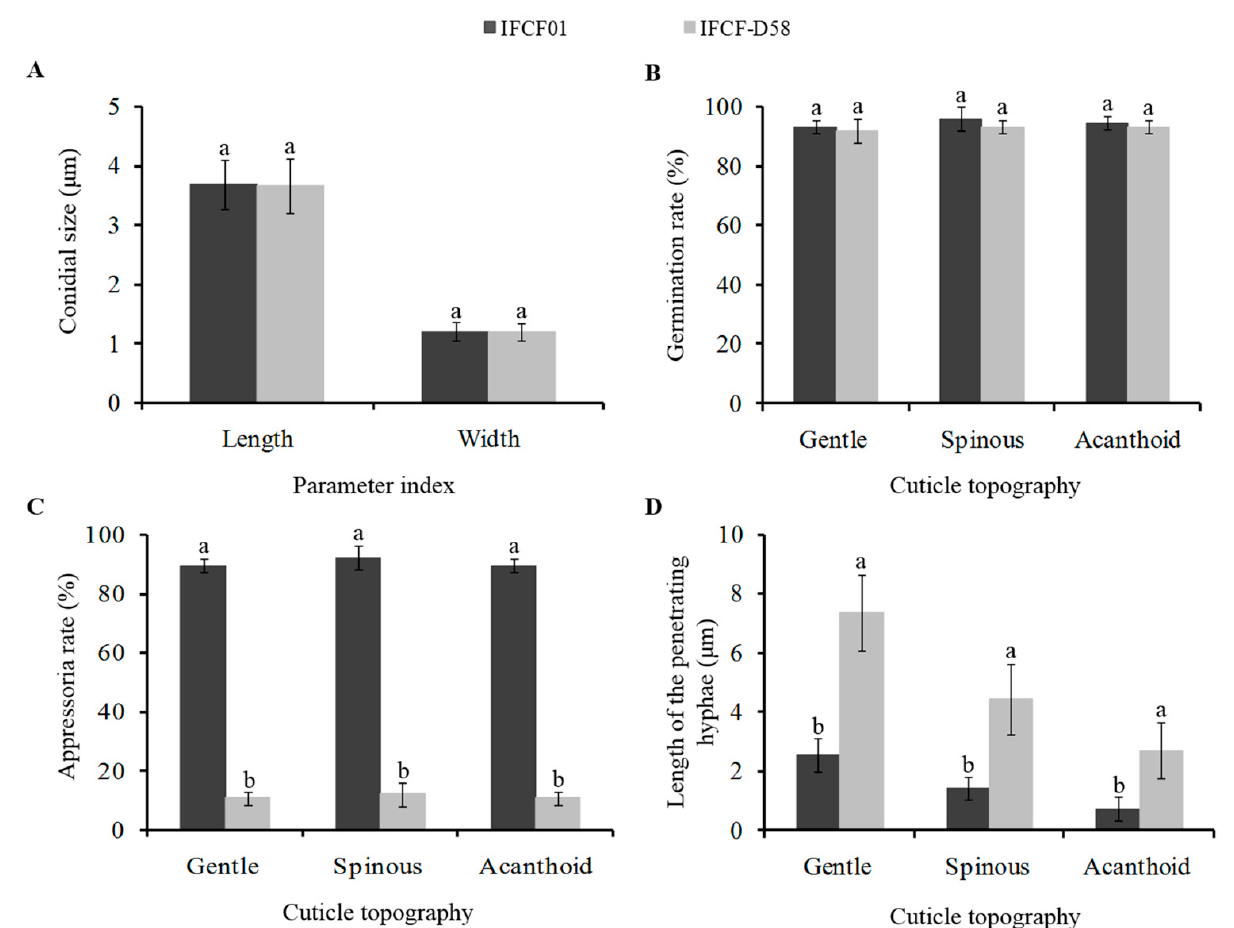
Figure 5. Comparison of conidial growth parameters of Cordyceps fumosorosea strains IFCF01 and IFCF-D58 on different cuticle topographies of Plutella xylostella larvae. ( A ) Conidia size, ( B ) Germination, ( C ) Appressoria, and ( D ) Penetration. Different lowercase letter(s) above the bars in the same cuticle topography indicate statistically significant differences (Tukey’s HSD test; P < 0.05).